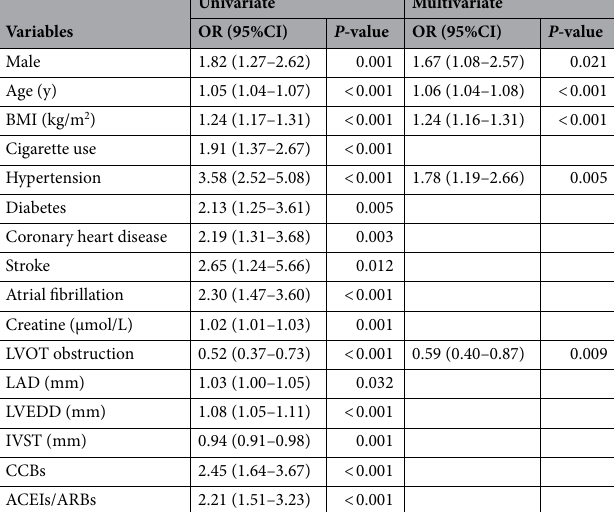
Table 3. Logistic regression between OSA and significant clinical variables from univariate analysis. Data are presented as odds ratio (95% confidence interval). OR: odds ratio; CI: confidence interval; OSA: obstructive sleep apnea; BMI: body mass index; LVOT: left ventricular outflow tract; LAD: left atrial diameter; LVEDD: left ventricular end-diastolic dimension; IVST: interventricular septum thickness; CCBs: calcium channel blockers; ACEIs: angiotensin-converting enzyme inhibitors; ARBs: angiotensin II receptor blockers.